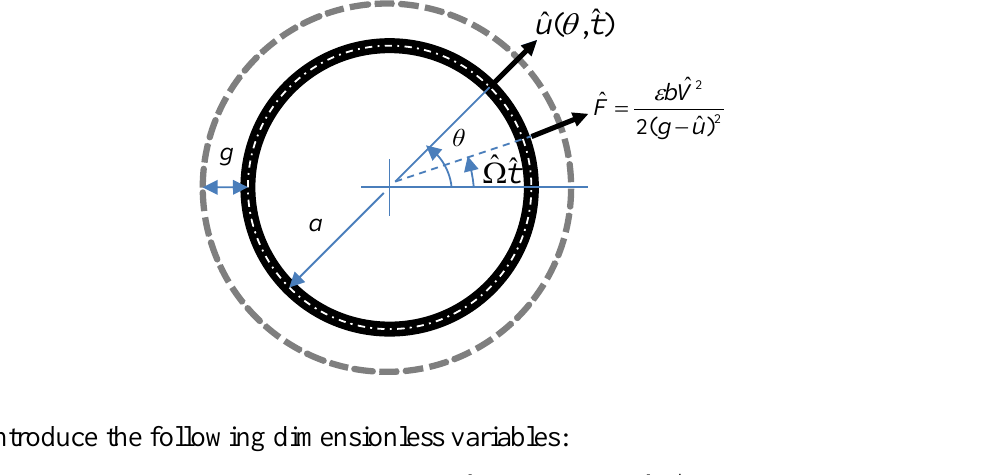
Figure 1. The schematic diagram of a flexible micro-ring driven by a traveling electrostatic